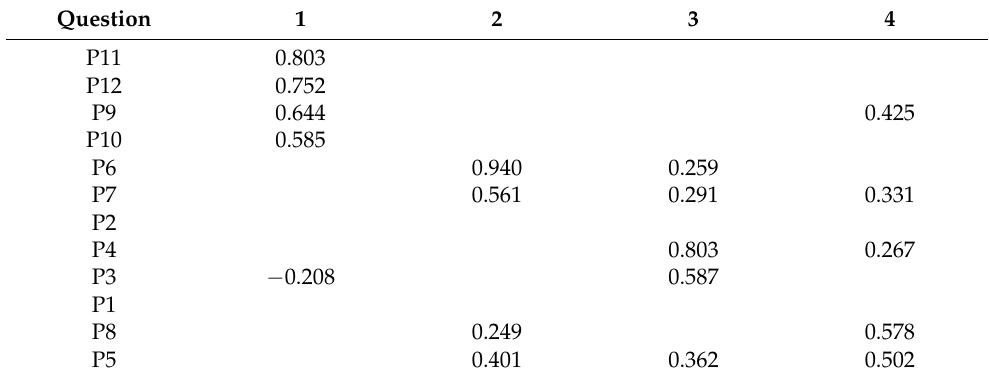
Table 12. Rotated factor matrix obtained using the extraction method of maximum likelihood and the rotation method of Varimax with Kaiser normalization, with rotation converged in 8 iterations.